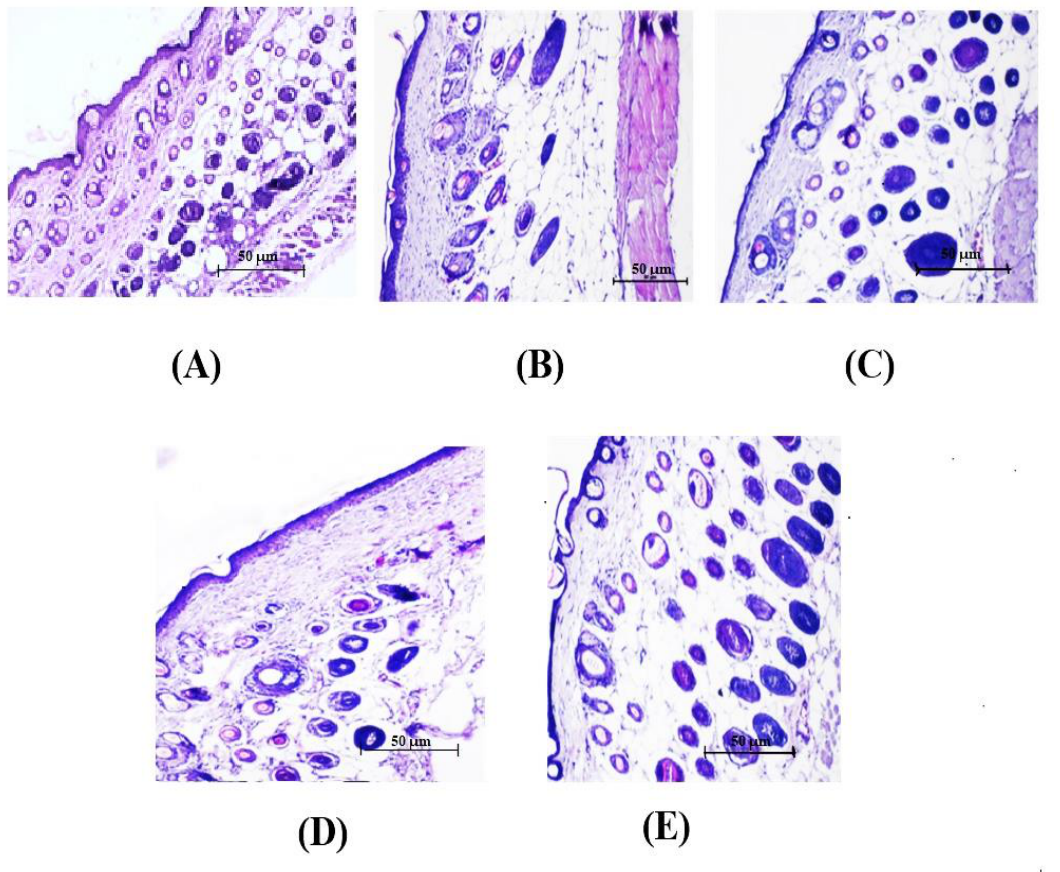
Figure 4. Photomicrographs of mouse skin illustrating the hydration of the skin. ( A ) Untreated skin; ( B ) skin treated with blank SLN gel base; ( C ) skin treated with THC-SLN dispersion; ( D ) skin treated with reference ointment, Tacroz ® Forte; and ( E ) and skin treated with THC-SLN gel.